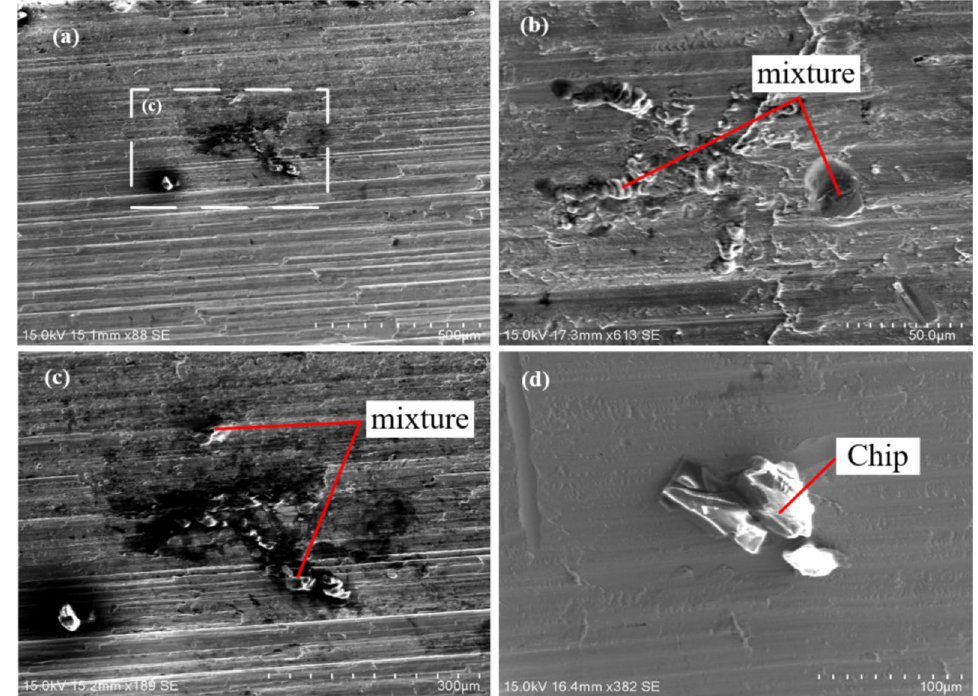
Figure 14 Surface adhesion of contour tooth bevel gear in dry